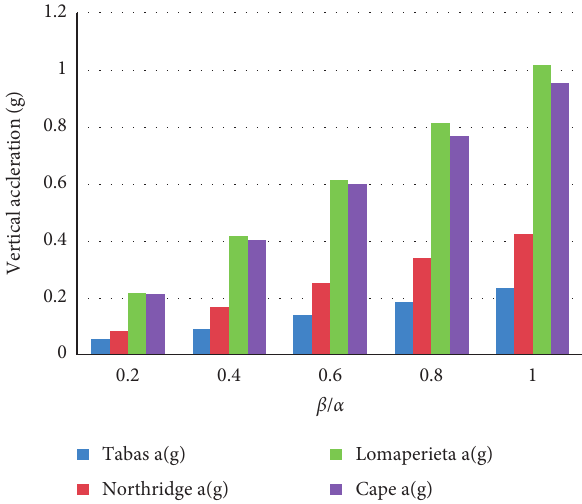
Figure 9: Maximum vertical acceleration of tunnel lining at loading 11 to